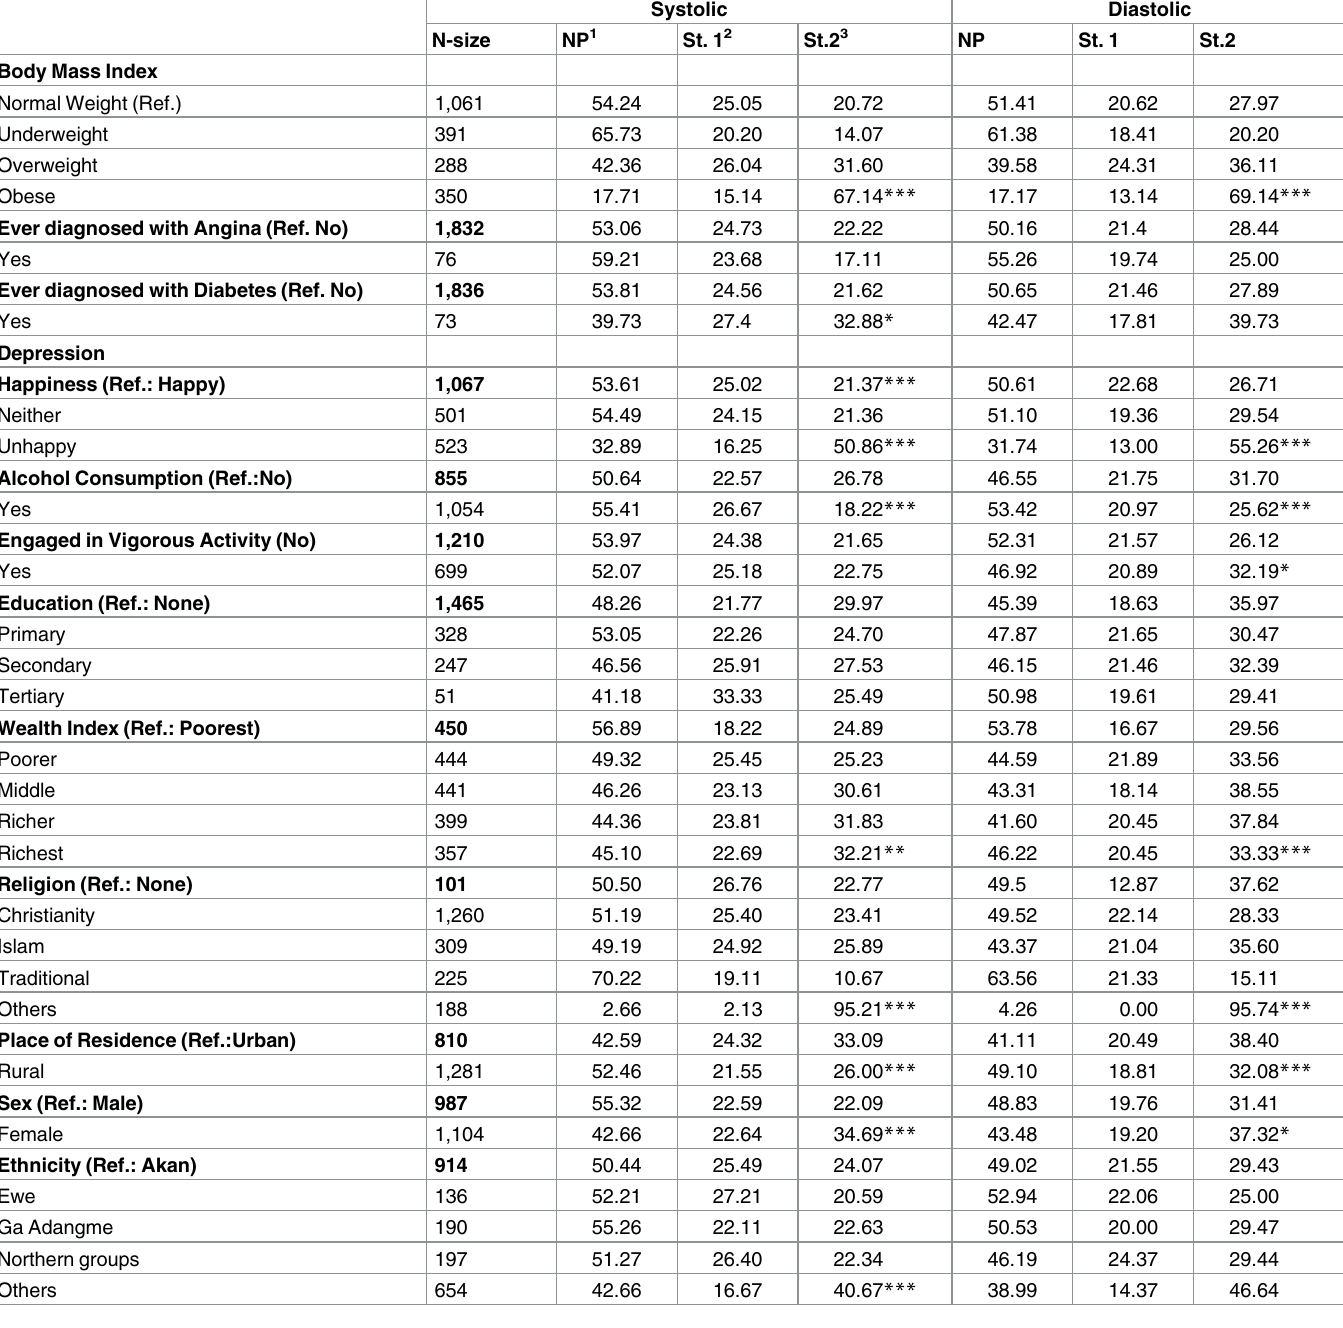
Table 1. Univariate and bivariate results of elderly obesity and its association with hypertension. Systolic Diastolic N-size NP 1 St. 1 2 St.2 3 NP St. 1